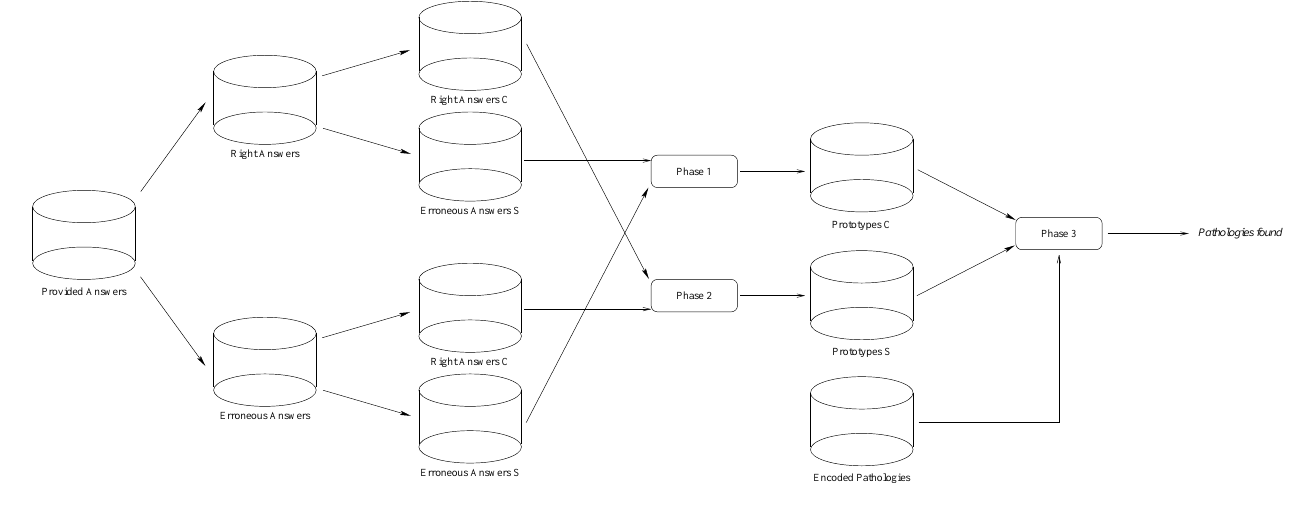
Figure 1. Phases of the technique